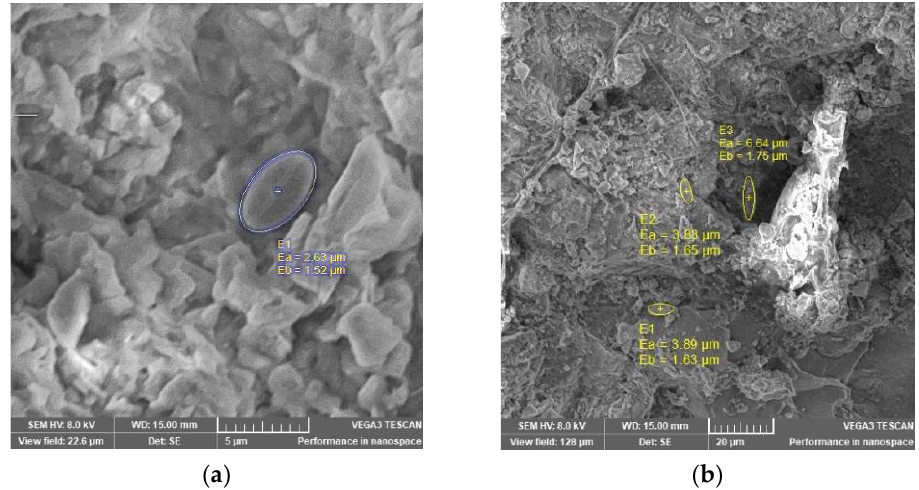
Figure 7. SEM images of NZ 1: ( a ) biofilm of sample S2 at 5 µm and ( b ) biofilm of sample S2 at 20 µm.